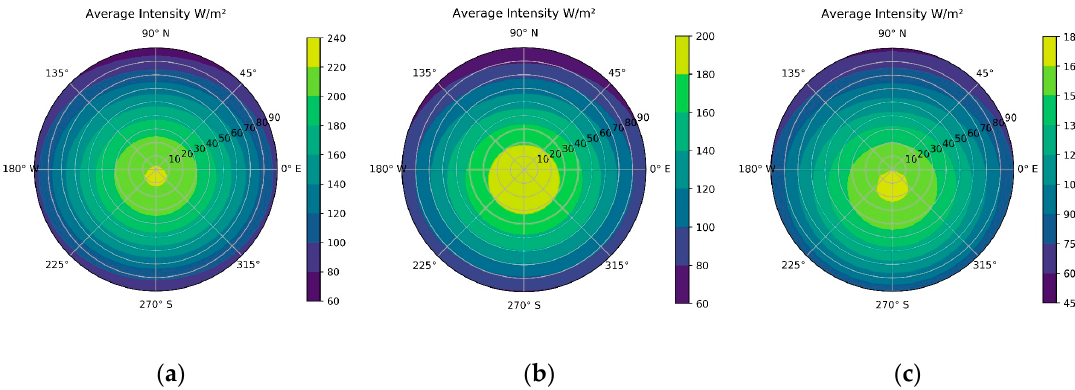
Figure 10. Distribution of annual average daily intensity as a function of tilt and azimuth angles of the slope. ( a ) Tri An; ( b ) Da Nang; ( c ) Tri An. Table 4. Electricity energy yield of 1 kWp horizontal Si-based commercial PV installation for different regions in Vietnam.